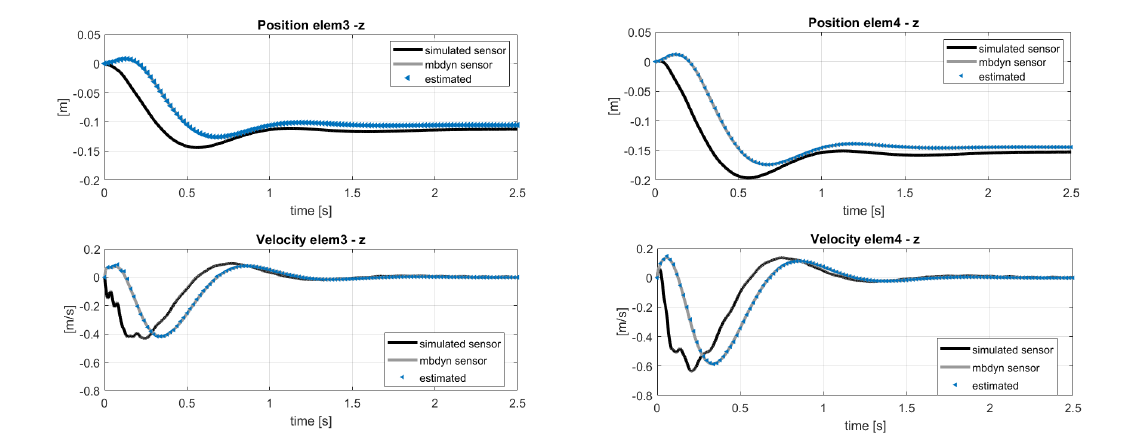
Figure 14. Estimation of the states used as sensors. Reference data from MBDyn.